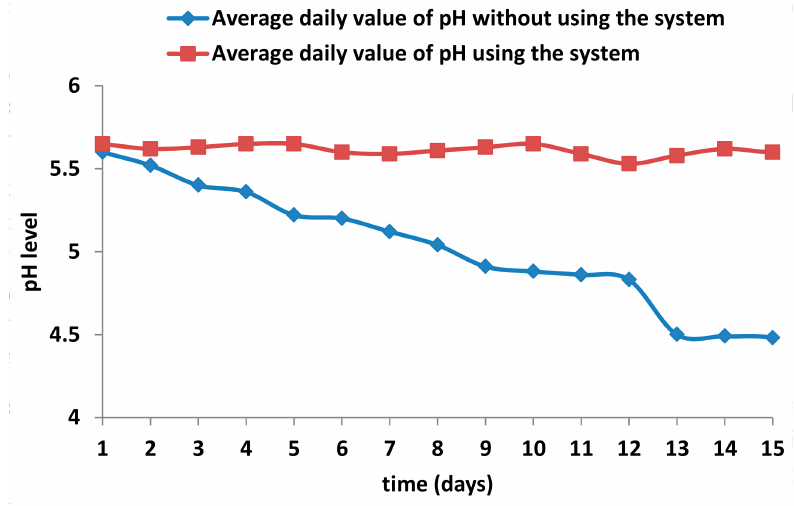
Figure 7. Evolution of pH values as a function of the time.